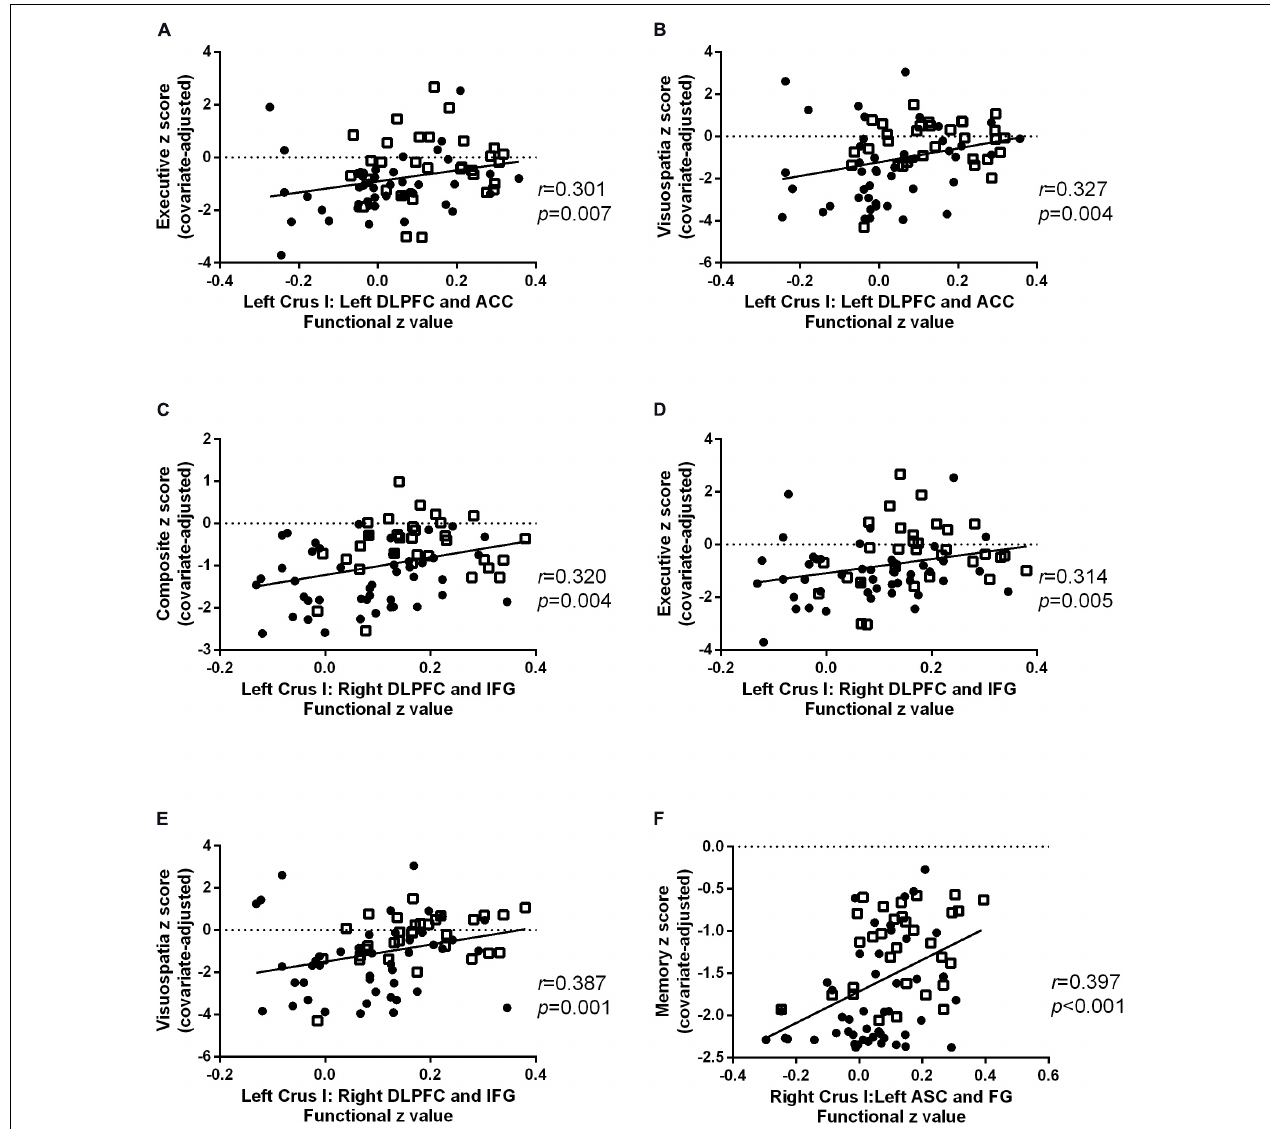
FIGURE 4 | Scatter plots for the significant cognitive-functional connectivity (FC) correlations in Alzheimer’s disease (AD) (circles) and amnestic mild cognitive impairment (aMCI) (squares). The strength of FC with left dorsolateral prefrontal cortex (DLPFC) and inferior frontal gyrus (IFG) positively correlated with (A) executive and (B) visuospatial function. The FC of left Crus I and correlated with (C) global cognition, (D) executive function, and (E) visuospatial function. The FC of right Crus I with left associative visual cortex (ASC) and fusiform gyrus (FG) positively correlated with memory (F)